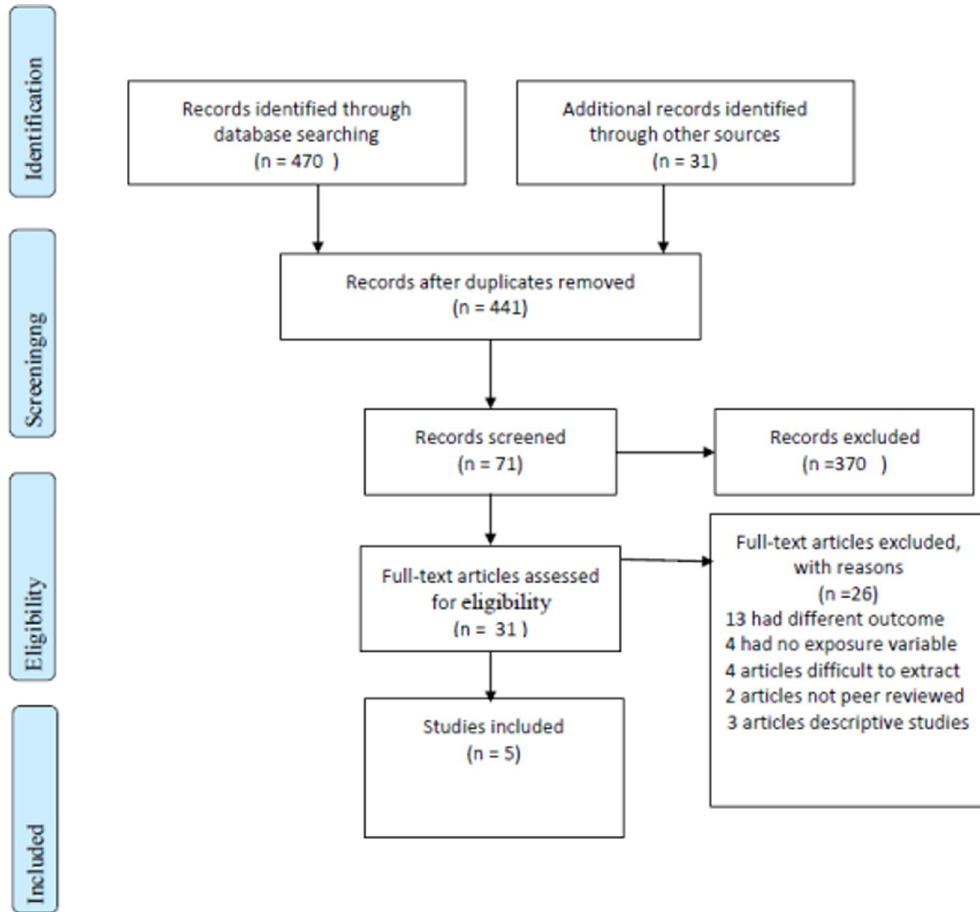
Fig 1. PRISMA flow diagram showing the procedure of selecting studies for meta-analysis in Ethiopia.